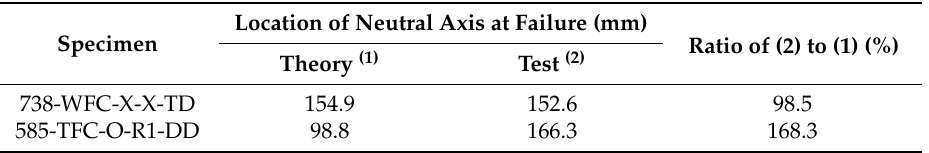
Figure 17. Measured strain distributions of the fully composite specimens: ( a ) 738-WFC-X-X-TD; ( b ) 585-TFC-O-R1-DD.